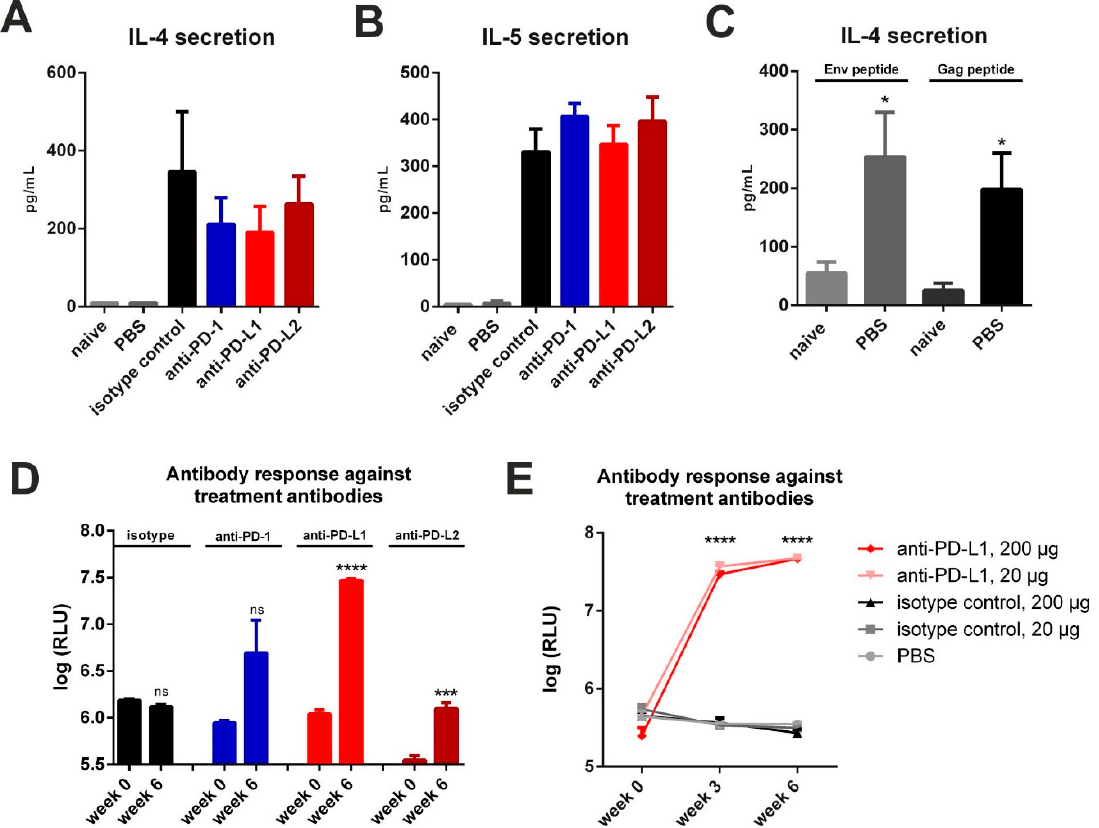
Figure 3. Checkpoint inhibition by monoclonal antibodies elicits a competitive immune response. Spontaneous secretion of IL-4 ( A ) and IL-5 ( B ) after three-day culture of splenocytes of BALB/c mice two weeks after immunization and two days after the last CPI treatment. Shown are mean values with SEM ( n = 2–4). ( C ) Antigen-specific IL-4 secretion in naïve and immunized mice receiving PBS treatment. Shown are mean values, SEM ( n = 5) and significant differences between groups (unpaired t -test, * p < 0.05). ( D ) Auto-antibody responses with 200 µg CPI administration in three-day intervals after prime-booster DNA immunization regimens. The plates were coated with respective treatment antibodies. Shown are mean values with SEM ( n = 3–4) and significant di ff erences between time-points (unpaired t -test, ns = not significant, *** p < 0.001, **** p < 0.0001). ( E ) Auto-antibody response with 20 and 200 µg CPI administration in three-day intervals after prime-booster VLP immunization regimens. The plates were coated with respective treatment antibodies. Shown are mean values with SEM ( n = 3–4) and significant differences between groups receiving anti-PD-L1 (programmed death-ligand 1) treatment against isotype control and PBS groups (two-way ANOVA analyses followed by Tukey’s multiple comparison test; **** p < 0.0001).